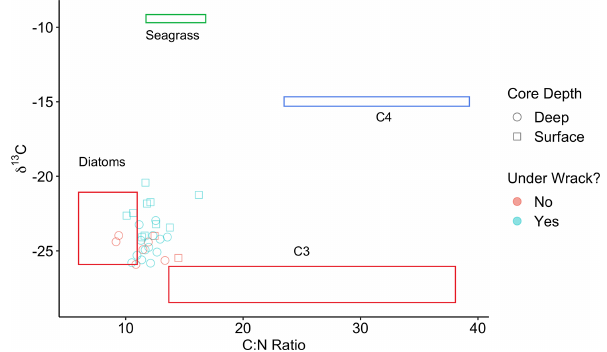
Figure 6. Points represent the δ 13 C and C : N ratios of Walker Salt Marsh sediment data, collected from underneath persistent wrack lines (blue) and from areas free of wrack (red) (see Fig. 1c). Sediment subsamples collected from the surface to 10cm deep are labeled as surface samples (square) and below 10cm are la- beled as deep samples (circle). Colored boxes represent sources (means ± SD) from diatoms (red), seagrass (green), C 4 salt marsh plants (blue), and C 3 salt marsh plants